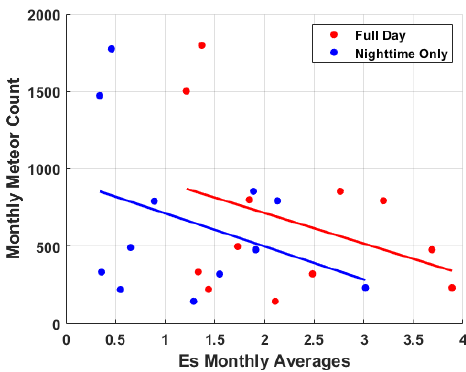
Figure 5. Relationship between foEs monthly averages and monthly meteor count observed at